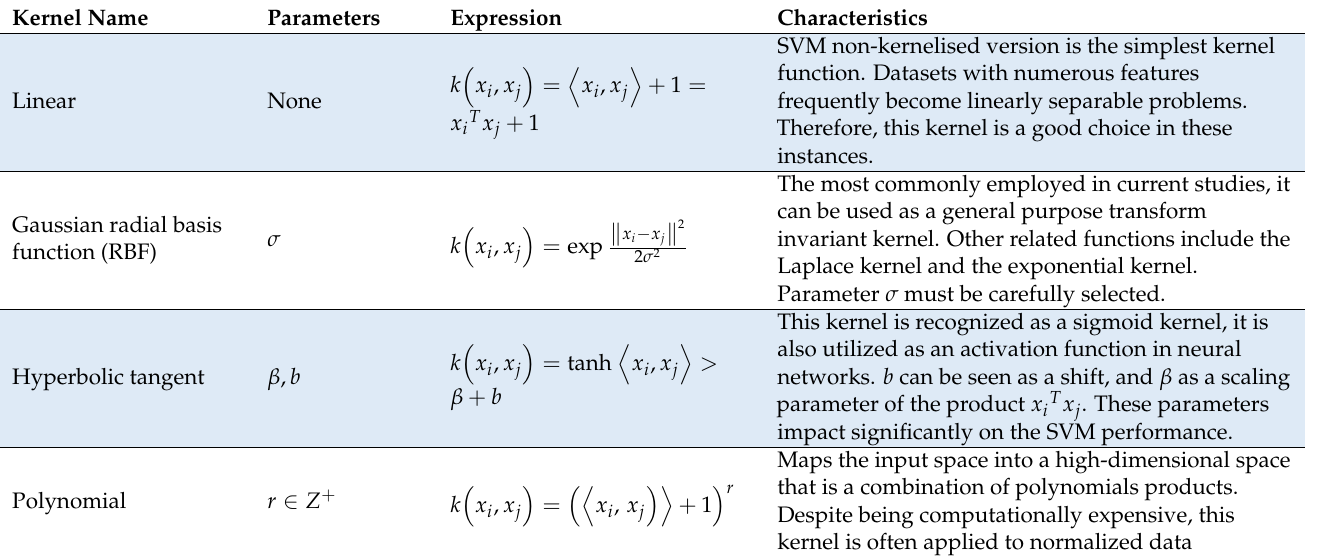
Table 2. The most commonly used SVM kernels and their